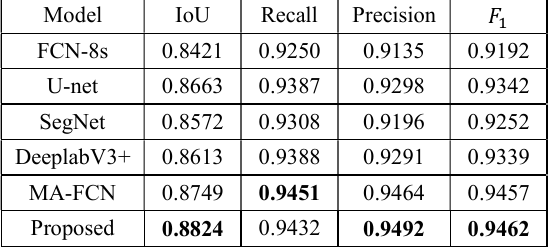
Table 1. Accuracy evaluation results of different models on the WUH dataset.